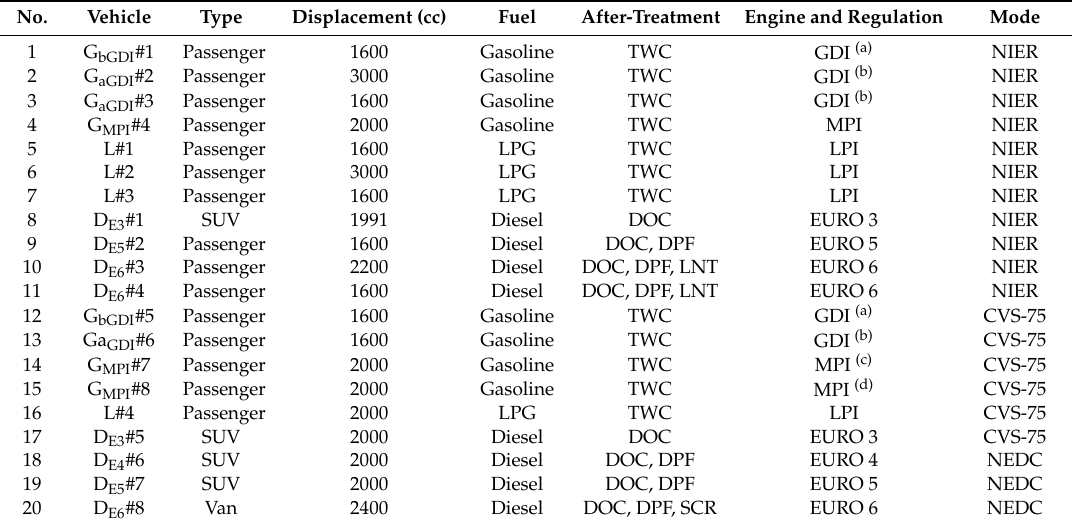
Table 1. Information on test vehicles measured using chassis dynamometer (Nos. 1–11 used for National Institute of Environmental Research (NIER) mode measurement, and Nos. 12–20 used for emission certification mode for vehicles in Korea).